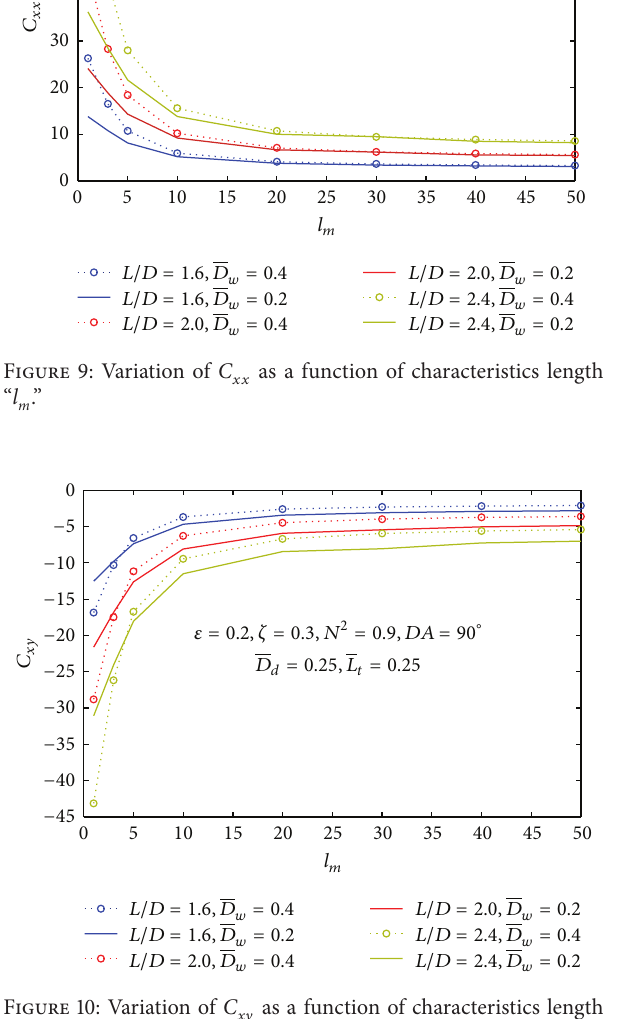
Figure 10: Variation of C 𝑥𝑦 as a function of characteristics length .” “ l m